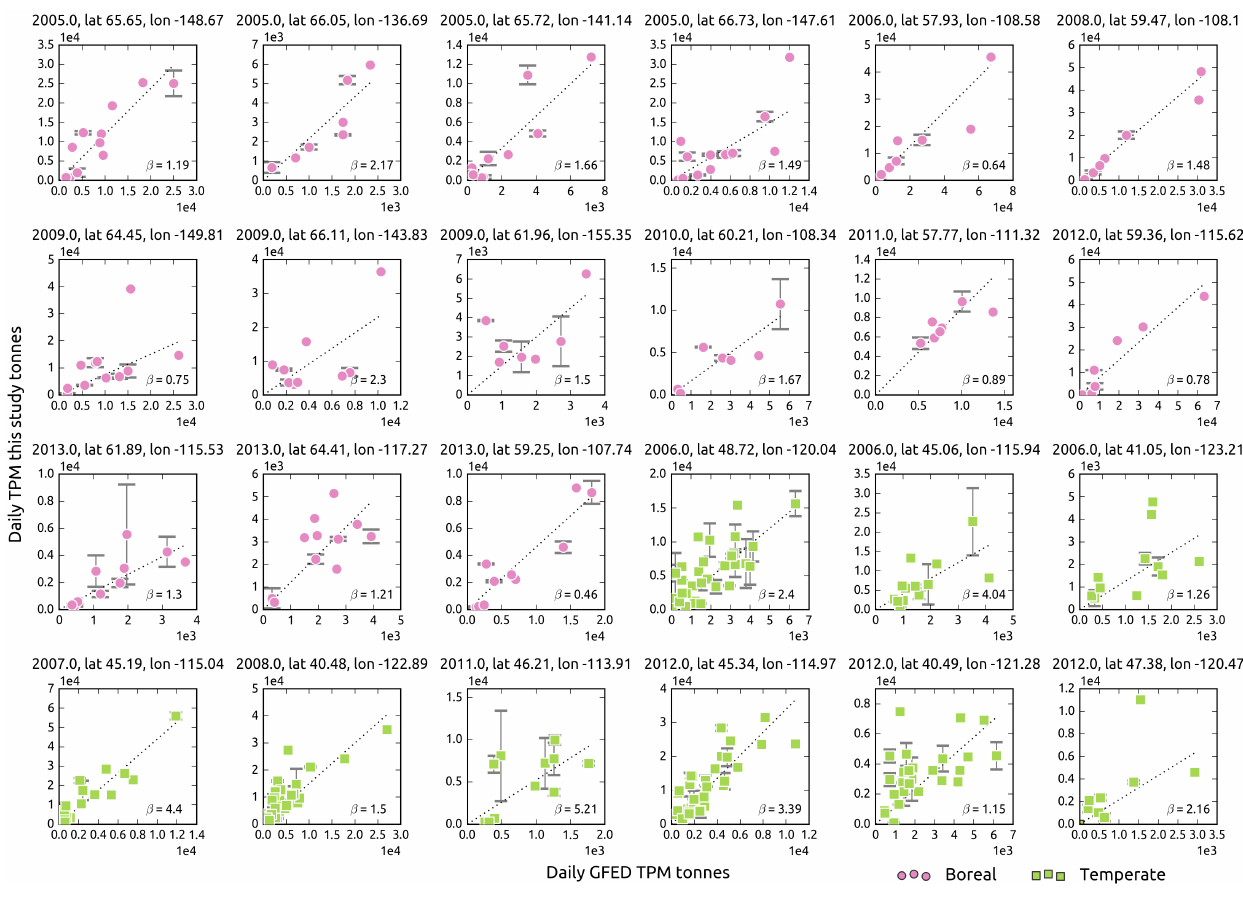
Figure 6. Daily estimated TPM from this study and GFED for individual fire events. Error bars represent difference between two TPM values for the days of emission for which two estimates were obtained. Robust linear fits are shown; β parameter indicates the slope.